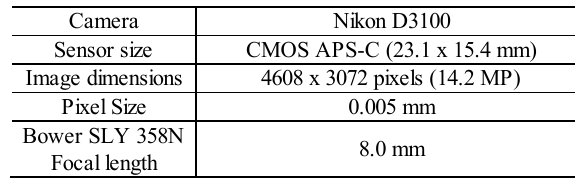
Table 1. Technical data of the Nikon D3100 digital camera and Bower fisheye